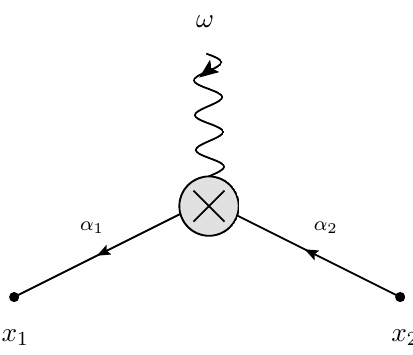
Figure 1 . Diagrammatic representation of the correlation function (2.26). Gray blob with a wavy line attached represents the flow operator J ω,S ( n ) . The arrow indicates the direction in which the particle propagates, index α i defines its